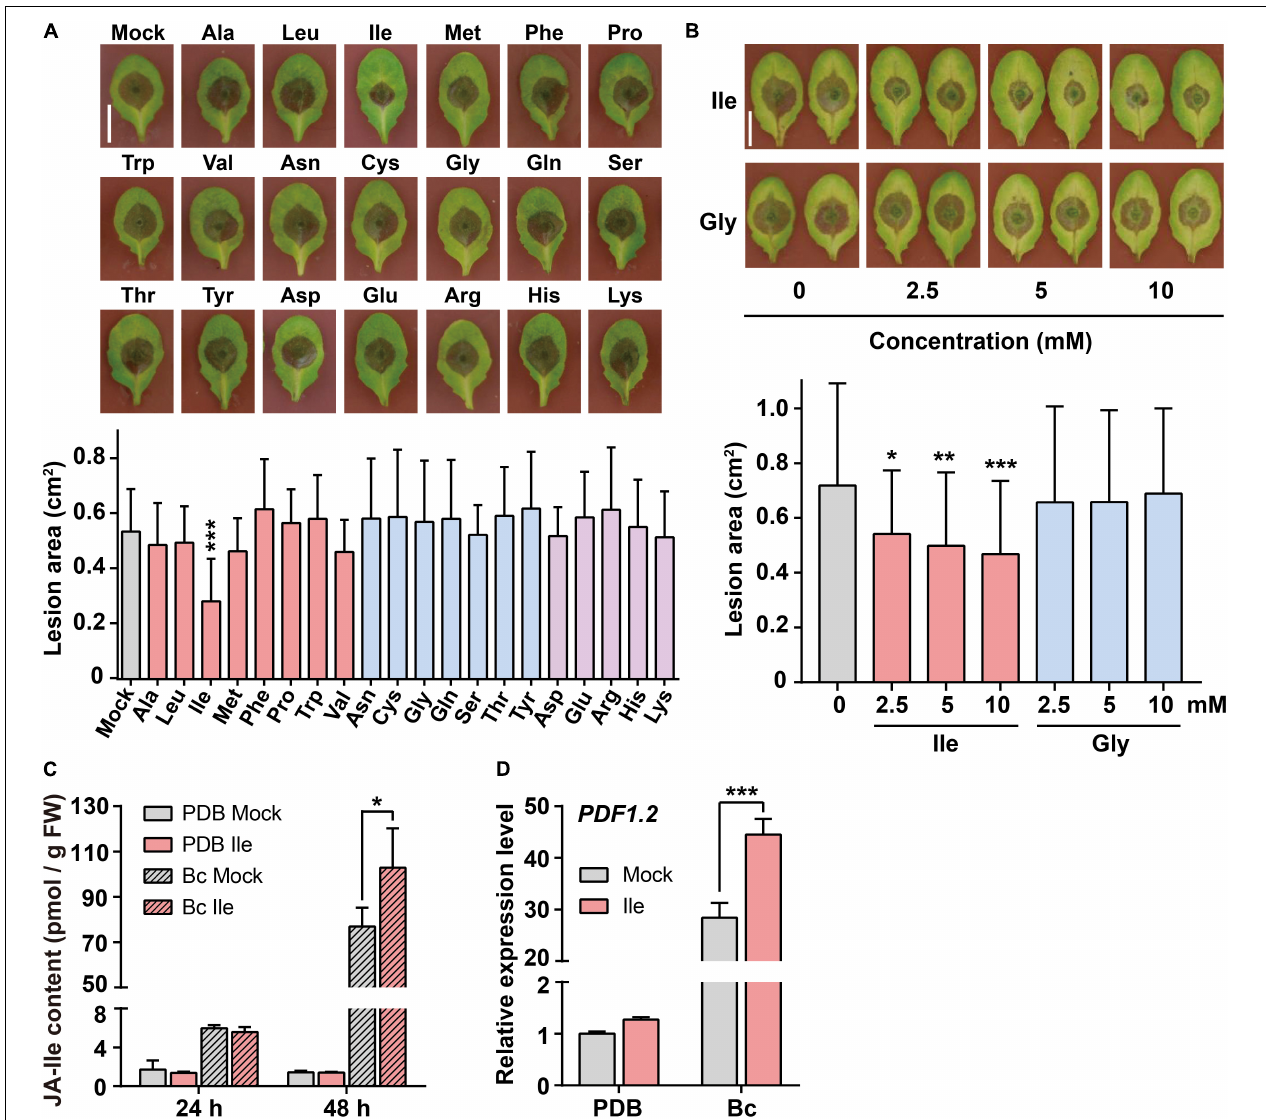
FIGURE 1 | Application of isoleucine (Ile) enhances plant resistance to Botrytis cinerea via elevating JA-Ile (jasmonoyl-isoleucine) level. (A) Representative phenotype and lesion area of wild-type (WT) leaves pretreated with different amino acids after B. cinerea infection for 3 days. Five-week-old WT plants were pretreated with 10 mM amino acids for 2 days before B. cinerea inoculation, including non-polar amino acids (i.e., Ala, Leu, Ile, Met, Phe, Pro, Trp, and Val), polar amino acids (i.e., Asn, Cys, Gly, Gln, Ser, Thr, and Tyr), acidic amino acids (i.e., Asp and Glu), and alkaline amino acids (i.e., Arg, His, and Lys). 0.05% Tween 20 solution (Mock) was used as a control. Scale: 1 cm. Data are means ± SD ( n = 28–47 leaves). (B) Representative phenotype and lesion area of WT leaves after B. cinerea infection for 3 days pretreated with different concentrations of Ile or Gly. Five-week-old plants were pretreated with 0, 2.5, 5, and 10 mM Ile or Gly for 2 days. 0.05% Tween 20 solution (0 mM) was used as control. Scale: 1 cm. Data are means ± SD ( n = 24–43 leaves). (C,D) JA-Ile concentration (C) and transcript level of the defensive gene PDF1.2 (D) in WT leaves after indicated treatments. Four-week-old WT plants were pretreated with 0.05% Tween 20 solution (Mock) or 10 mM Ile for 2 days, and then leaves were sprayed with Potato Dextrose Broth (PDB) or B. cinerea spores suspension (Bc) for 24 or 48 h. Then, the 7th–9th rosette leaves were collected for quantification of JA-Ile contents, and PDF.1.2 transcript level (48 h). Data are means ± SD. In panel (C) , n = 4 samples. In panel (D) , n = 3 samples, each sample contains three leaves; ACTIN8 is used as the internal control. Statistical significances were calculated via Student’s t -test Mock and amino acid treatment (* p < 0.05; ** p < 0.01; *** p <